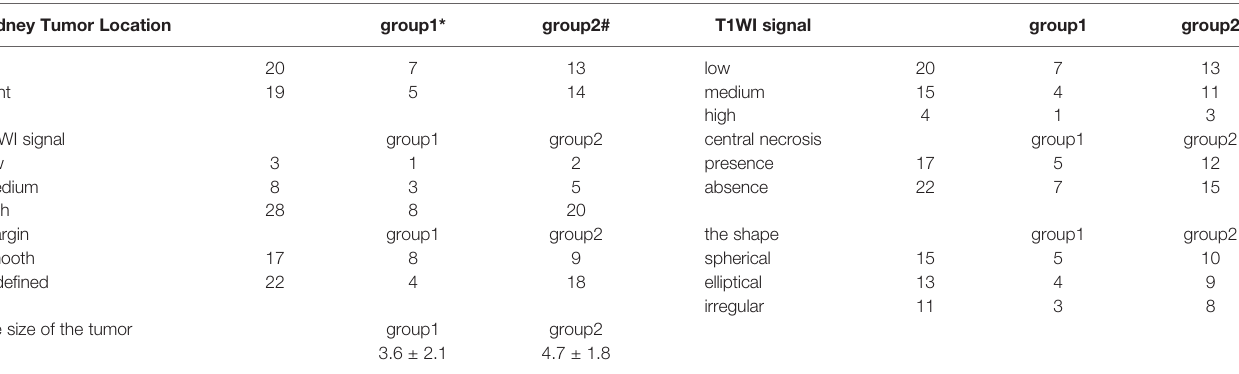
TABLE 2 | Image features of kidney tumors.